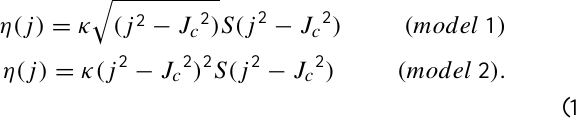
respectively. Empty blocks indicate no change in the param- eters from the line